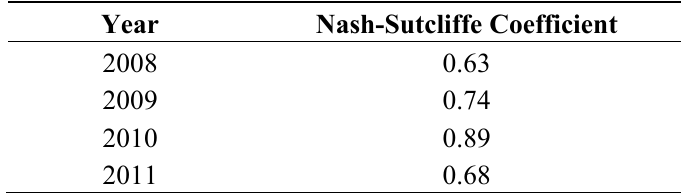
Table 8. Nash-Sutcliff coefficient for the separate stormwater system at the CEHQ gauging station for the 1 May to 30 September period.